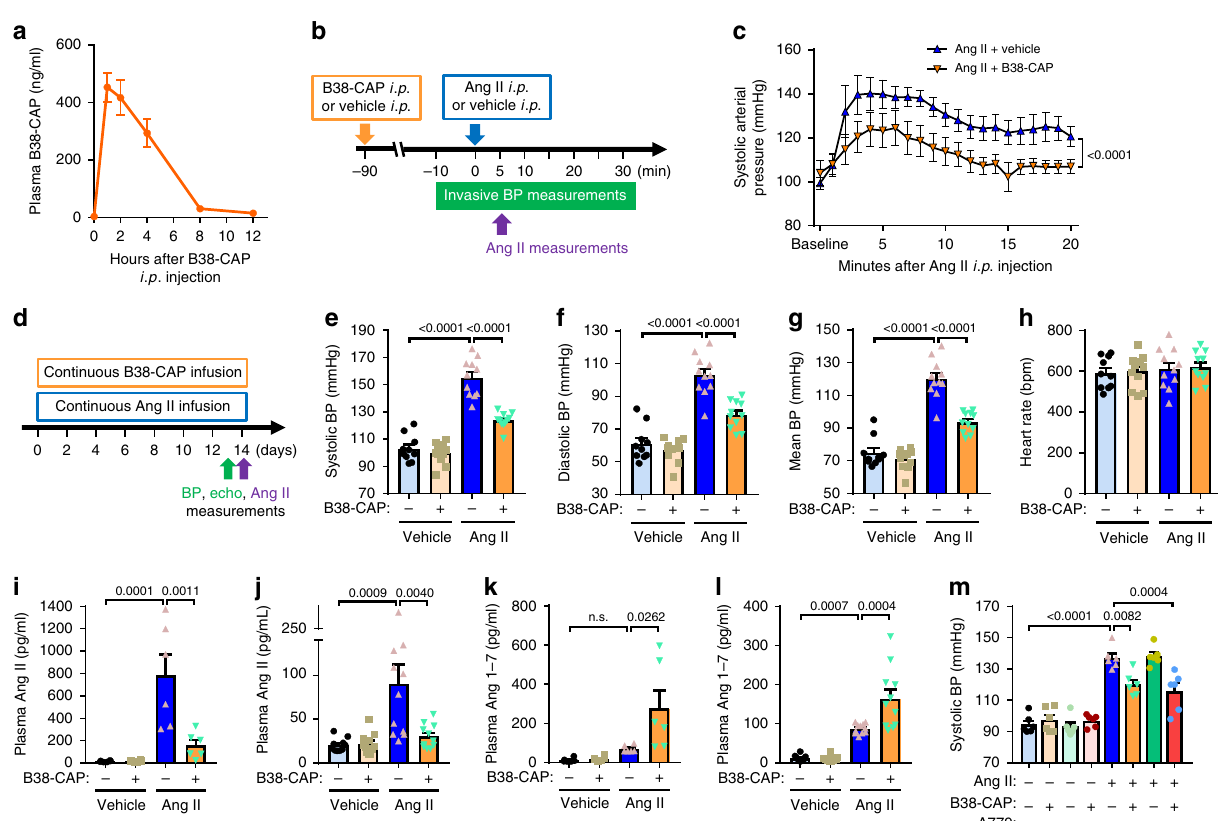
Fig. 2 Effects of B38-CAP on plasma angiotensin II levels and blood pressure in mice. a Plasma B38-CAP levels in mice after intraperitoneal injection of B38-CAP (2 mg kg − 1 ). B38-CAP activity was measured with the B38-CAP substrate Nma-Leu-Pro-Lys(Dnp) ( n = 4, 6, 8, 6, 6, and 6 for 0, 1, 2, 4, 8, and 12 h, respectively). b , c Invasive measurements of arterial blood pressure (BP). Experimental protocol ( b ); mice pretreated with B38-CAP (2 mg kg − 1 i.p.) had liquid- fi lled catheter inserted into carotid artery for BP measurements and Ang II (0.2 mg kg − 1 i.p.) was injected and BP measured. Systolic arterial pressure is shown ( c ). ( n = 6 mice per group). d – h Blood pressure measurements with conscious mice. Experimental protocol ( d ); mice were treated